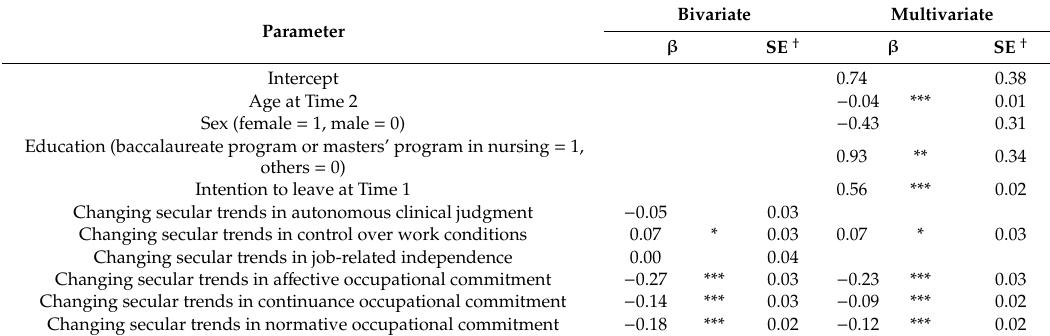
Table 3. Generalized estimating equation results ( n = 1778).